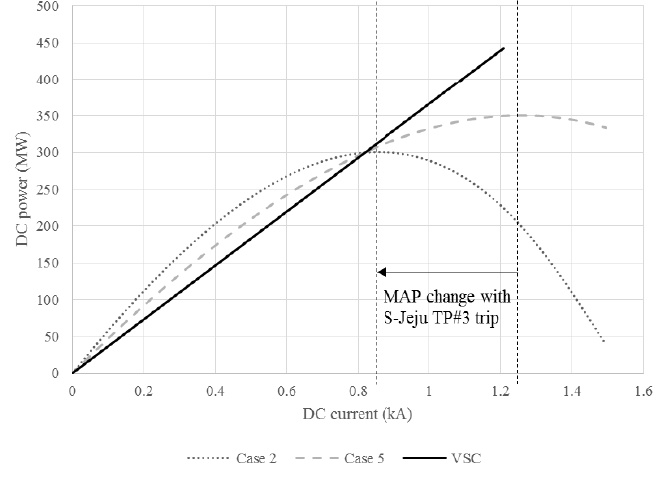
Figure 6. Maximum Power Curve of the Jeju system following different generation cases.